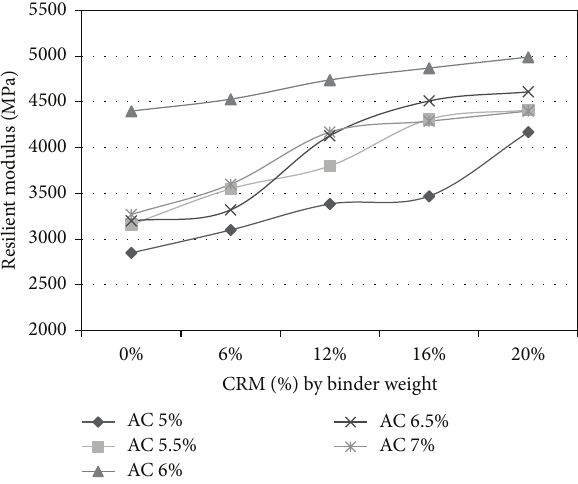
Figure 8: VIM results versus CRM content.